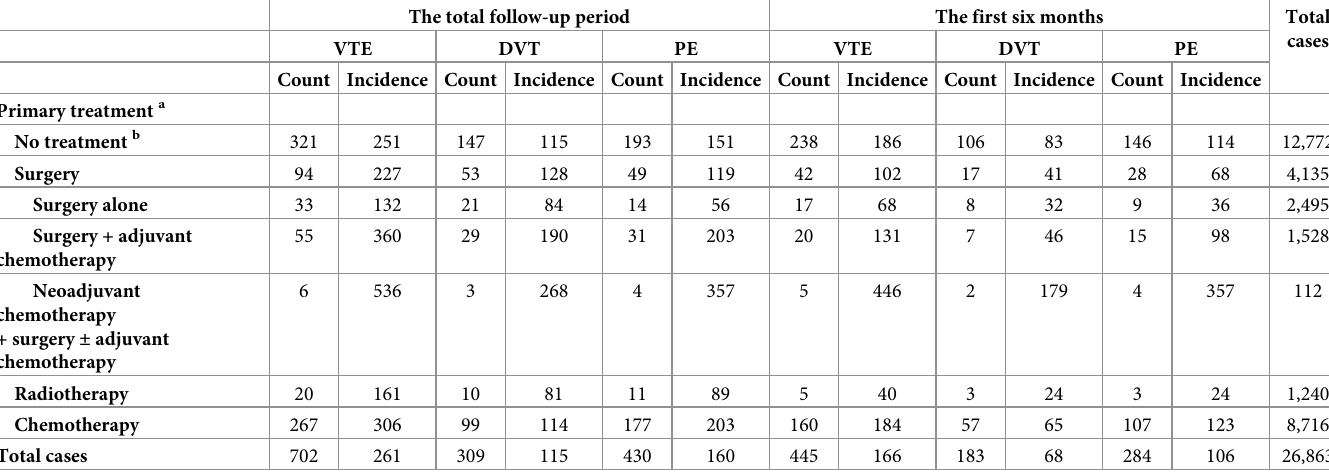
Table 2. Incidence (per 10,000 women) of VTE in various primary treatments in women with ovarian cancer (HIRA claims data of